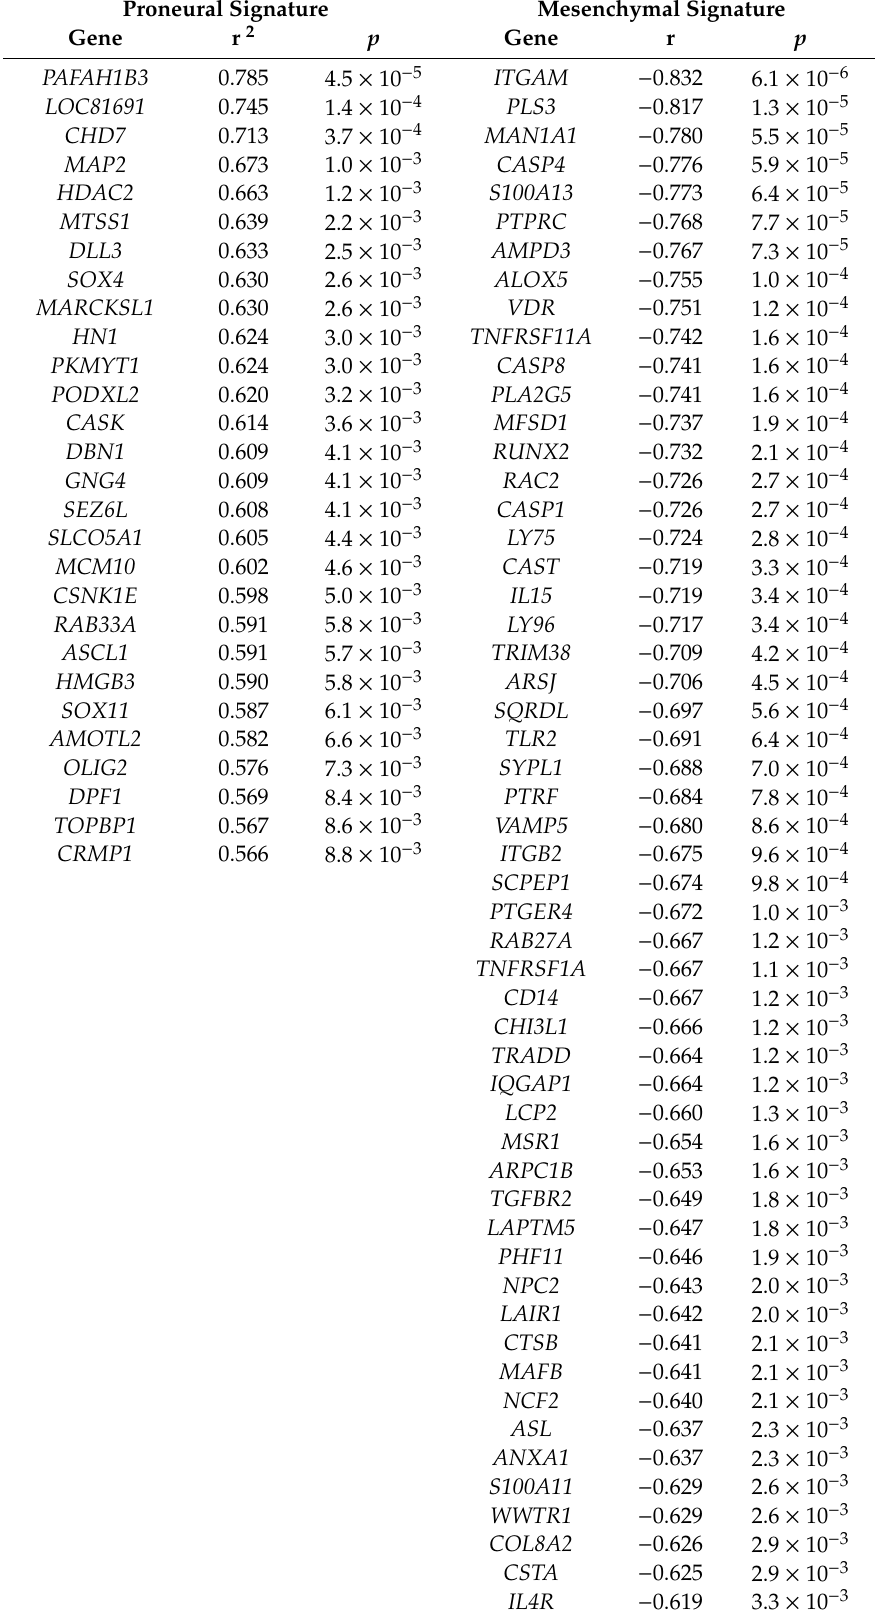
Table 1. Correlations between PATZ1 and the proneural and mesenchymal signature in pediatric glioblastoma ( n = 34)